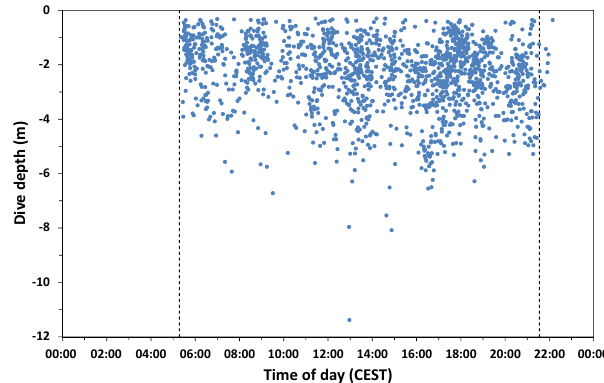
Figure 5. Diurnal rhythm in diving activity of northern gannets in the German Bight in 2015. Data are for the period 12–31 May 2015 and are based on dive recordings of three adults breeding on He- ligoland. Each dot represents one dive, showing the maximum depth during the dive. Vertical dashed lines indicate sunrise and sunset for the median day of the period covered.